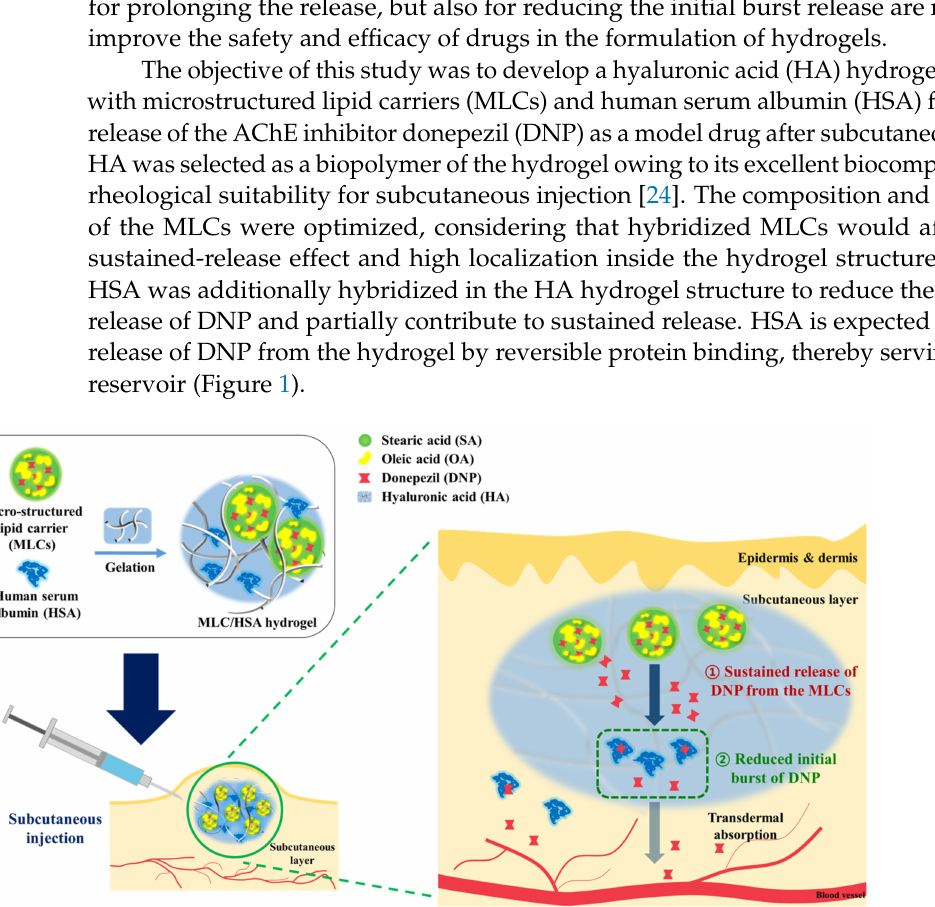
Figure 1. Schematic illustration of the developed hydrogel for sustained release of donepezil with the reduced initial burst